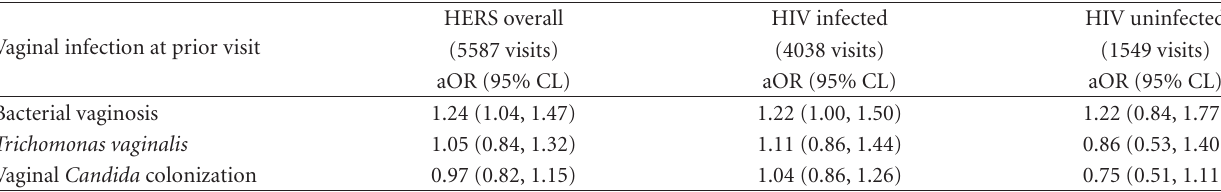
Table 3: Odds ratios for incident human papillomavirus among all HERS women and by HIV status. Vaginal infection at prior visit